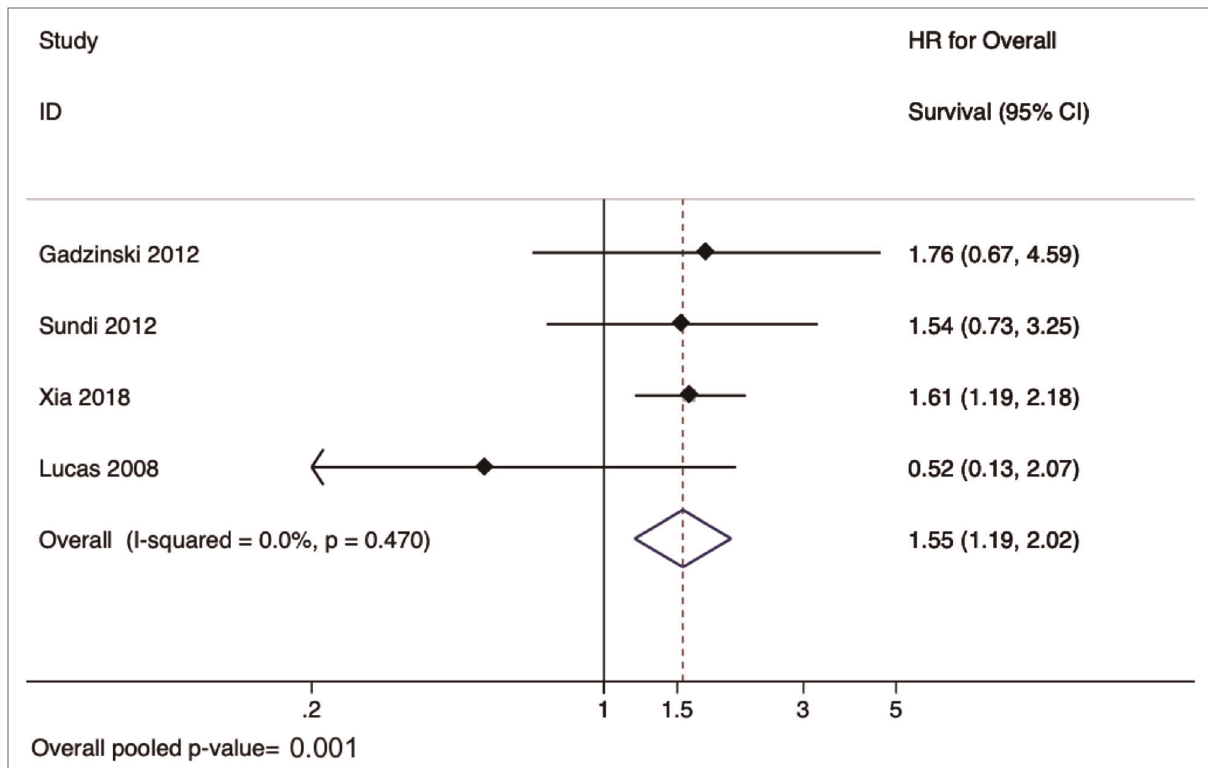
FIGURE 3 Forrest plot for meta-analysis on effect of delayed radical nephro-ureterectomy on overall survival in upper tract urothelial carcinoma.